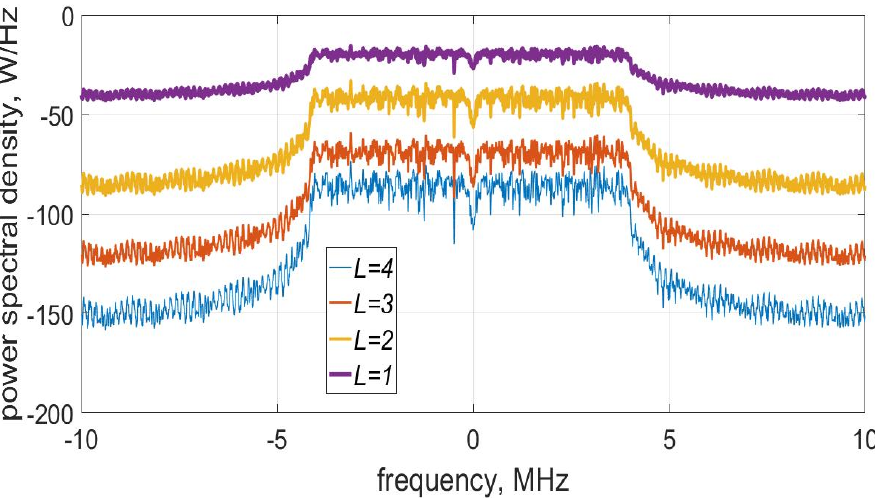
Figure 4. PSD of FBMC for L = 1, 2, 3, and 4.